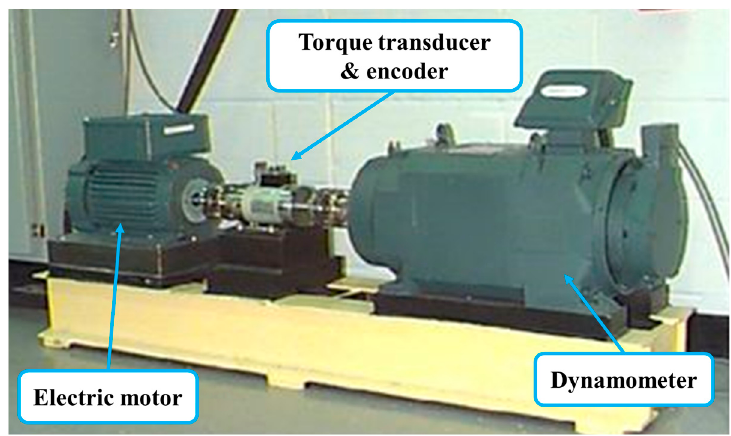
Figure 7. The CWRU bearing test rig.